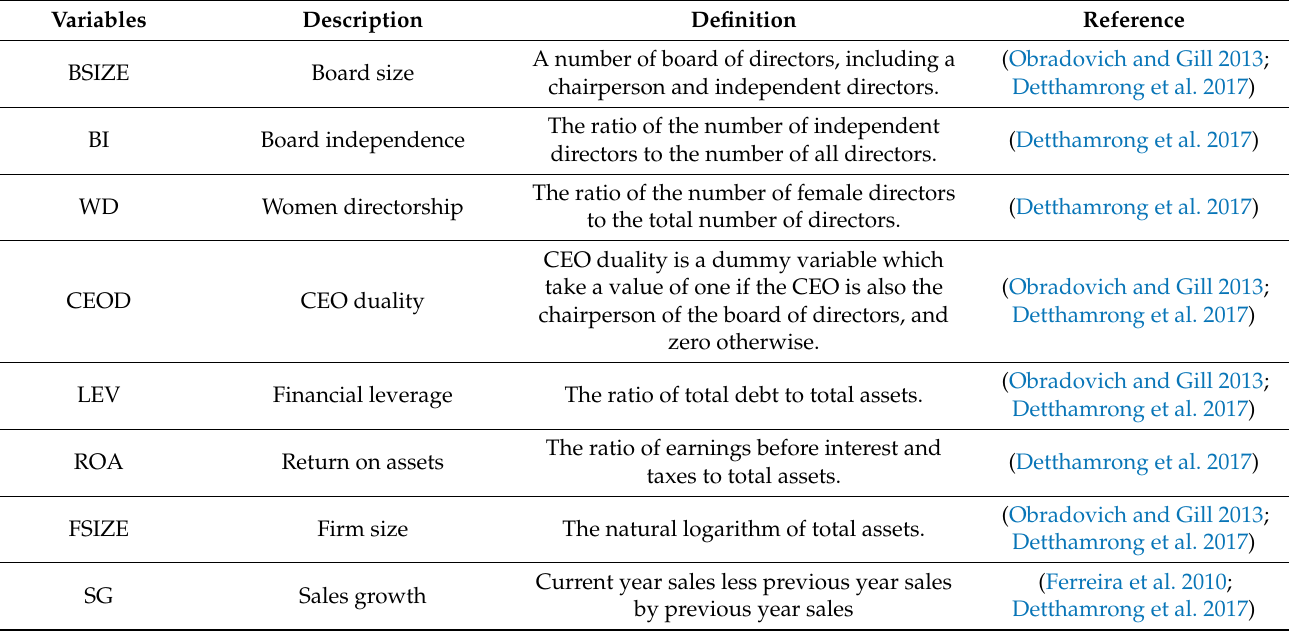
Table 2. Variables’ abbreviation, description, definition and